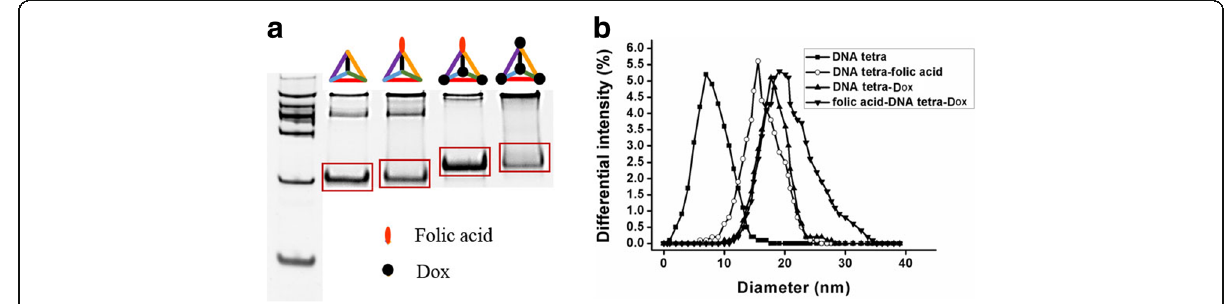
Fig. 2 Characterization of DNA tetra with different constituents. a Left to right: DNA ladder, DNA tetra, folic acid-DNA tetra, folic acid-DNA tetra-Dox, and DNA tetra-Dox imaged in 8% SDS-PAGE. b The size distribution of DNA tetra, folic acid-DNA tetra, folic acid-DNA tetra-Dox, and DNA tetra-Dox detected via dynamic light